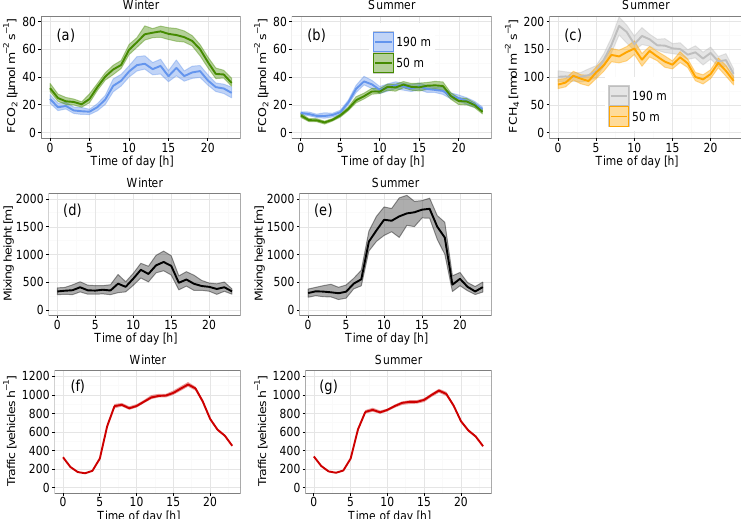
Figure 4. Mean diurnal profiles of CO 2 fluxes for (a) winter (DJF), and (b) summer (JJA) for the data period 15 September 2011–31 Decem- ber 2013; (c) CH 4 fluxes in summer observed at the BT tower site (190ma.g.l.) and the KCL site (50ma.g.l.) over the period 19 August– 1 October 2015; mixing height obtained from Doppler LIDAR measurements for (d) winter and (e) summer (Bohnenstengel et al., 2015); road traffic counts (f) winter and (g) summer (average of 246 counting stations distributed throughout the London conurbation; source: Transport for London, 2012 data). The shaded areas represent the 95% confidence